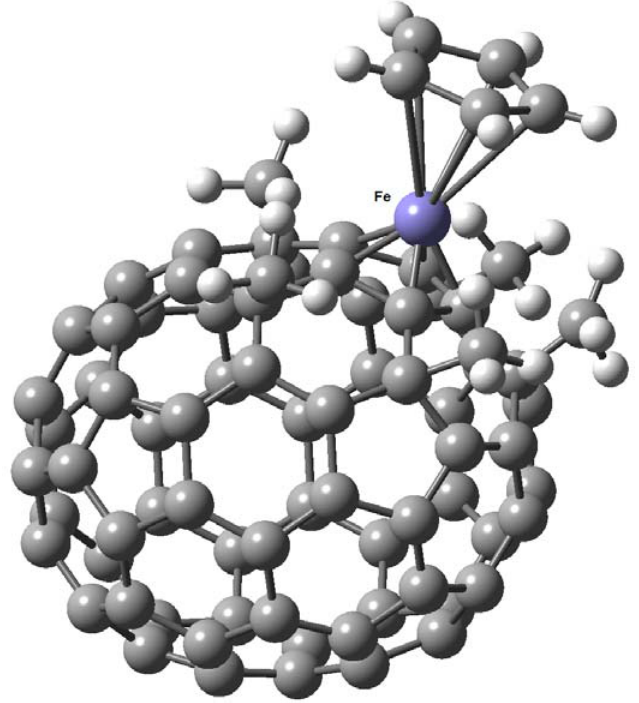
Figure 11. Molecular structure of ferrocene/C diffraction (Reproduced from [47] with permission).